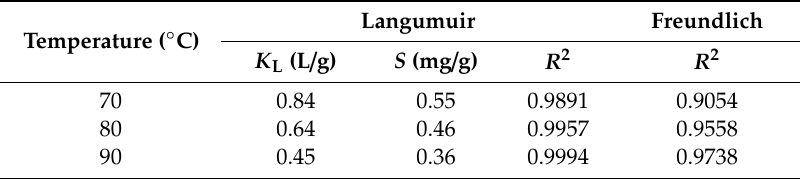
Table 2. Langmuir and Freundlich adsorption parameters of tannic acid on